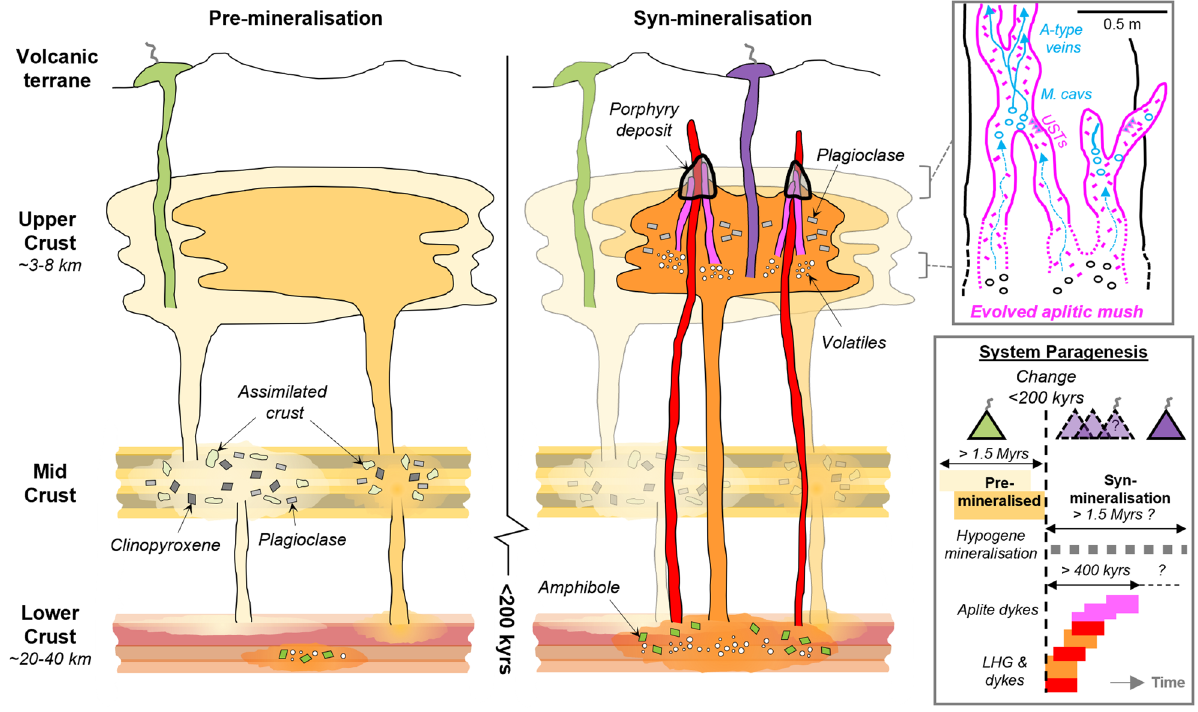
Figure 10. A rapid change in magmatic plumbing to tap porphyry-mineralising magmas: Simplified system paragenesis and conceptual cross-section through the porphyry deposit forming magmatic system. A long lived (> 1.5 Myrs) evolution and contemporaneous emplacement of precursor plutonics, with volcanic activity, was followed by a rapid (< 200 kyrs) change in magmatic plumbing to tap fertile porphyry deposit-forming magmas from a ~ 20–40 km deep lower crustal staging ground where they predominately underwent amphibole- dominated fractional crystallisation. From this zone of melt evolution, fertile magmas were emplaced into the shallow crust to form plutons and porphyry stocks, and underwent further differentiation at ~ 3–8 km depth, including extensive plagioclase crystallisation, with episodic upward injection of multiple generations of aplite dykes for > ~ 400 kyrs, which likely acted as crystal mush conduits for mineralising fluids 33 . As mineralising fluids exploited these conduits, porphyry deposit formation continued episodically for potentially in excess of 1.5 Myrs, and may have been co-eval with volcanism. M. cavs = miarolitic cavities, USTs = unidirectional solidification textures. Vein nomenclature after 51 . Modified after 5,33,67